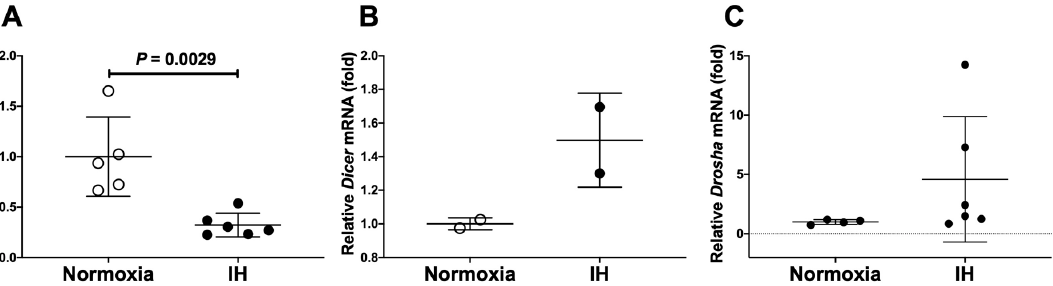
Figure 8. The levels of ( A ) miR-499 , ( B ) Dicer mRNA, and ( C ) Drosha mRNA of P19.CL6 cells treated with normoxia or IH for 24 h. The levels of miR-499 and Dicer and Drosha mRNAs were measured by real-time RT-PCR using U6 (for miR-499 ) and Rig/RpS15 (for Dicer and Drosha ) as endogenous controls. The miR-499/mRNA levels exposed to normoxia were set to 1.0. Data are expressed as mean ± SD for each group. The statistical analyses were performed using Student’s t -test. These results suggest that miR-499 plays a key role in the post-transcriptional regu- lation of mRNA levels of Reg IV and Hgf . To investigate whether Reg IV and Hgf expression in IH is regulated by miR-499, miR-499 mimic and non-specific control RNA (miR-499 mimic NC) were introduced into differentiated P19.CL6 cells with IH/normoxia exposure, and the mRNA levels of Reg IV and Hgf were measured by real-time RT-PCR. As shown in Figures 9 and 10, we found that IH-induced increases in Reg IV and Hgf mRNAs, and IH-induced increases in Reg IV and Hgf in the culture medium, were abolished by the introduction of the miR-499 mimic, but not by the miR-499 mimic NC. These findings indicate that IH stress downregulated the miR-499 level in cardiomyocytes (Figure 8), and that the levels of Reg IV and Hgf mRNAs were increased via a miR-499 mediated mecha- nism.